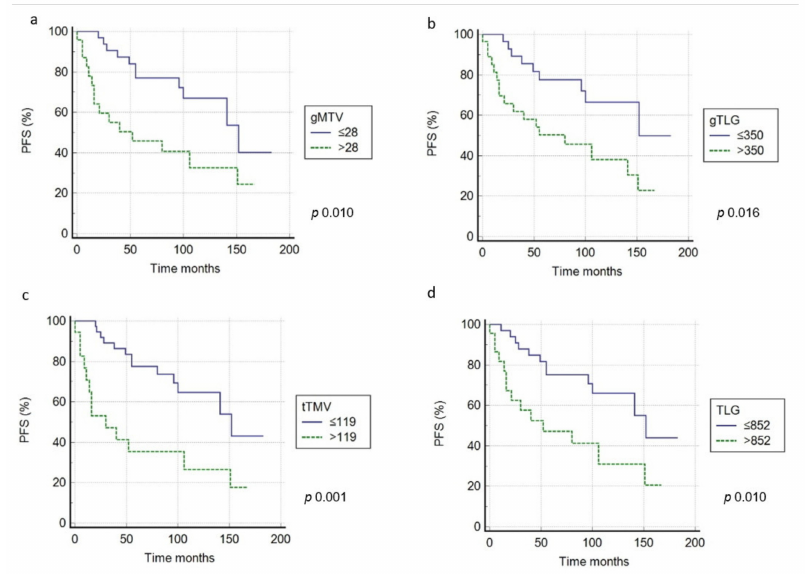
Figure 2. PFS curves according to pretreatment gMTV ( a ), gTLG ( b ), tMTV ( c ), and TLG ( d )